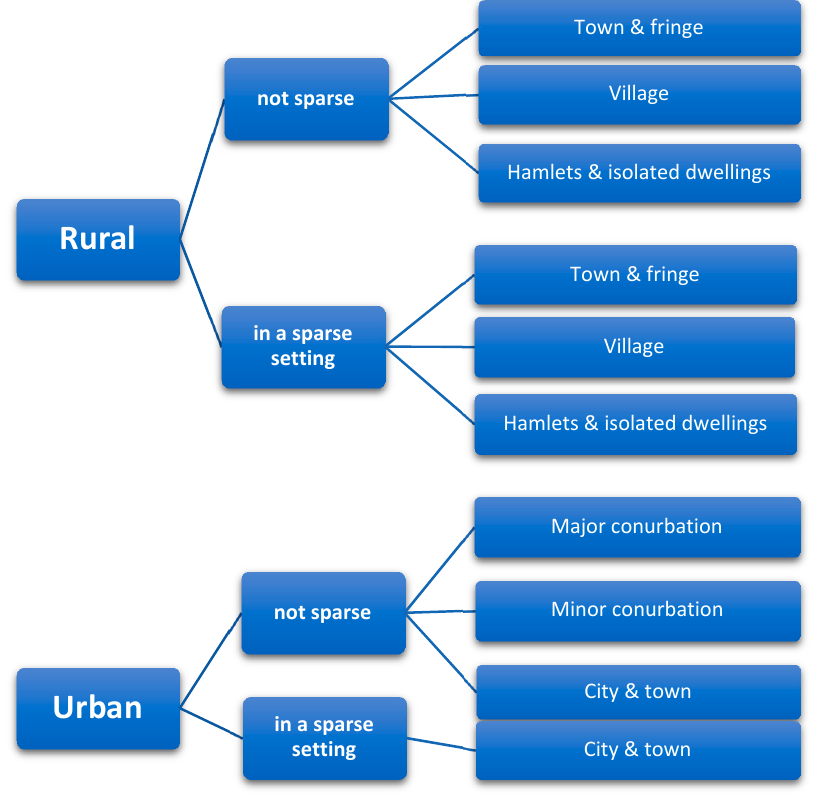
Figure 2. RUC2011 typology, output area level [25] .